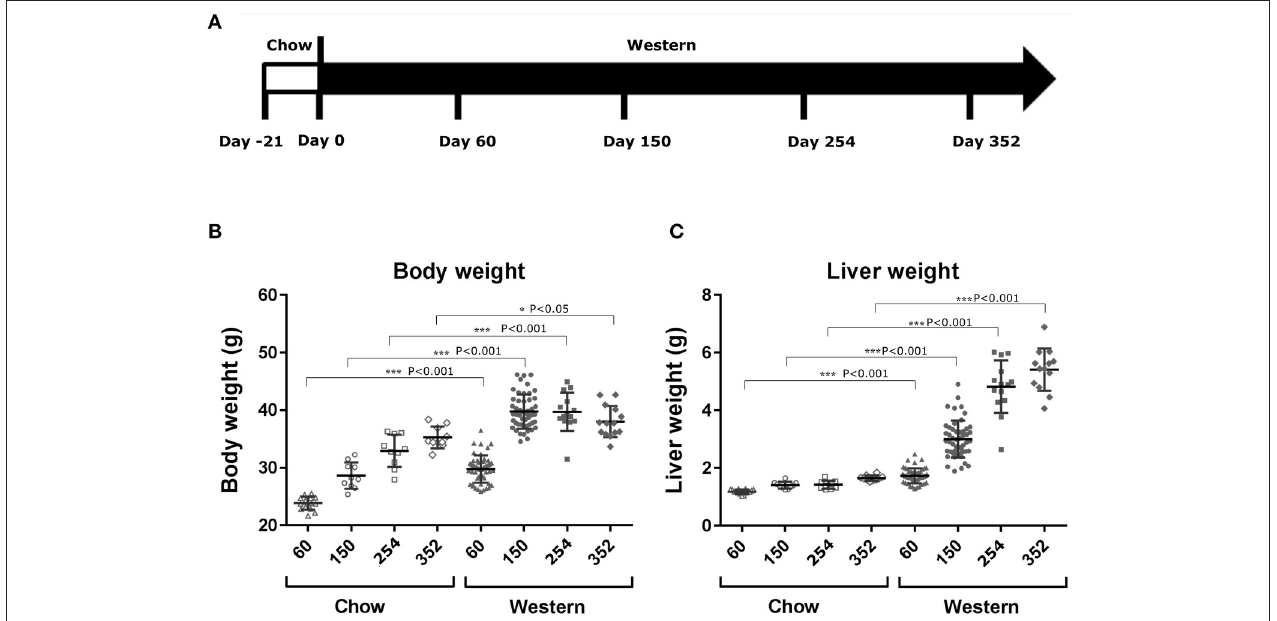
FIGURE 1 | Changes in body and liver weight after the treatment with Western diet. Male C57BL/6J mice were fed Western diet as described in (A) . Their body weight (B) was recorded. Their liver weight (C) was measured immediately after euthanasia. Two-tail T -test was used to calculated P -values of body weight or liver weight between mice fed on chow or Western diet for the same time periods (* P < 0.05; *** P < 0.001).